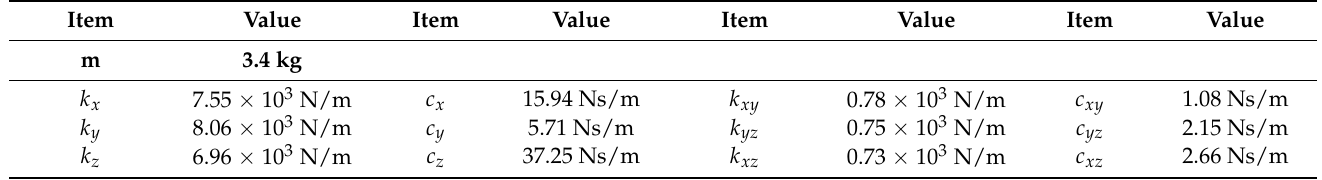
Table 2. Estimated parameters for a three-degree-of-freedom (DOF) coupled model.